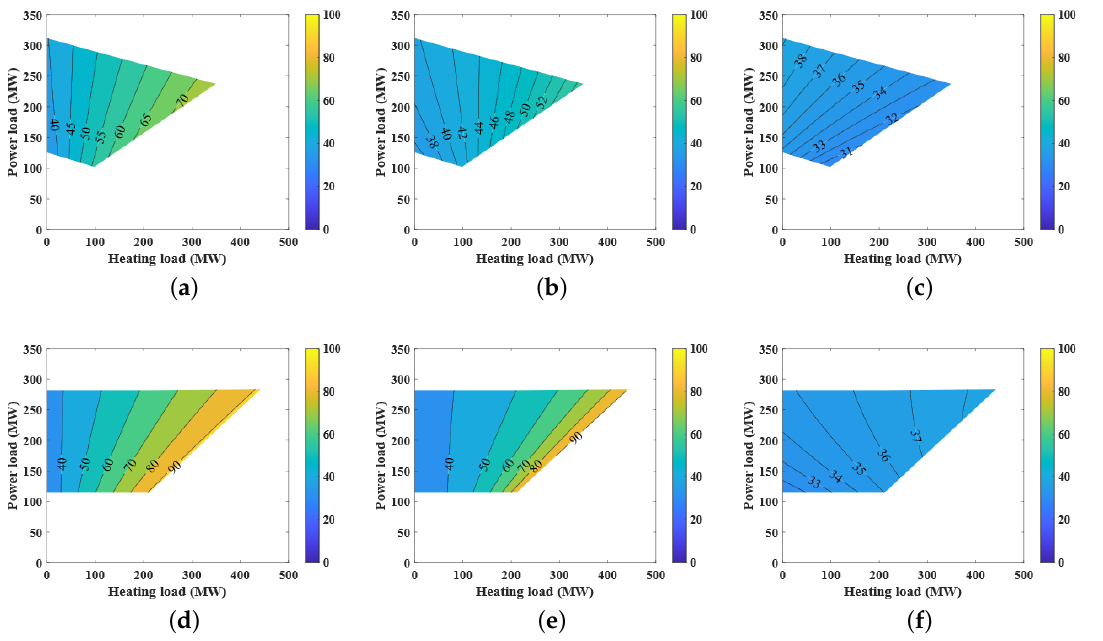
Figure 6. Efficiencies in the feasible operational region: ( a ) η g , CHP of EC system; ( b ) η e , CHP of EC system; ( c ) η ex of EC system ( T C = 20 ◦ C); ( d ) η g , CHP of HBP system; ( e ) η e , CHP of HBP system; g , CHP ( f ) η ex of HBP system ( T C = 20 ◦ g , CHP